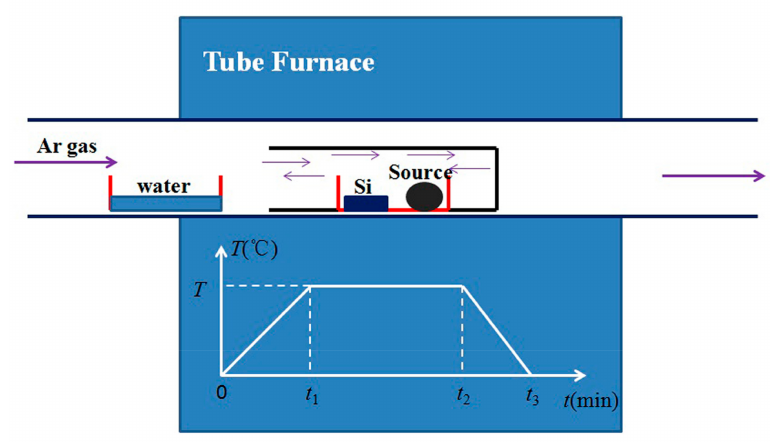
Figure 1. Schematic illustration of ZnO nanomaterial fabricating process using the system with a horizontal quartz tube placed in the